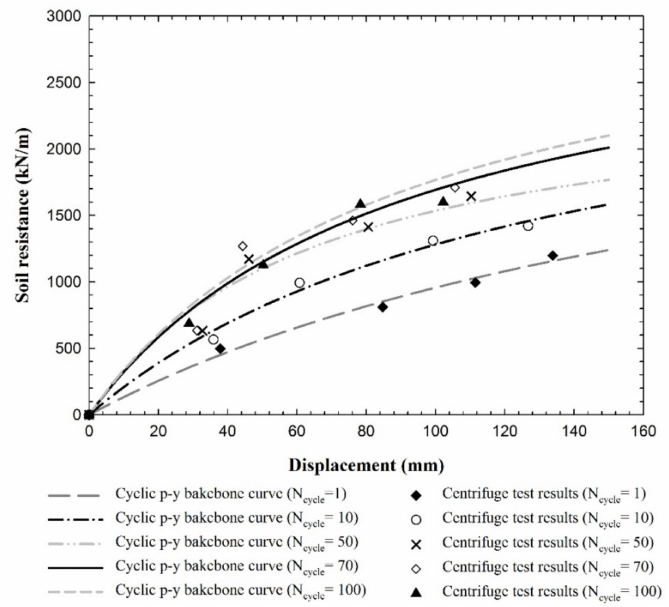
Figure 13. Cyclic p-y backbone curve at a depth of 2 m, according to number of